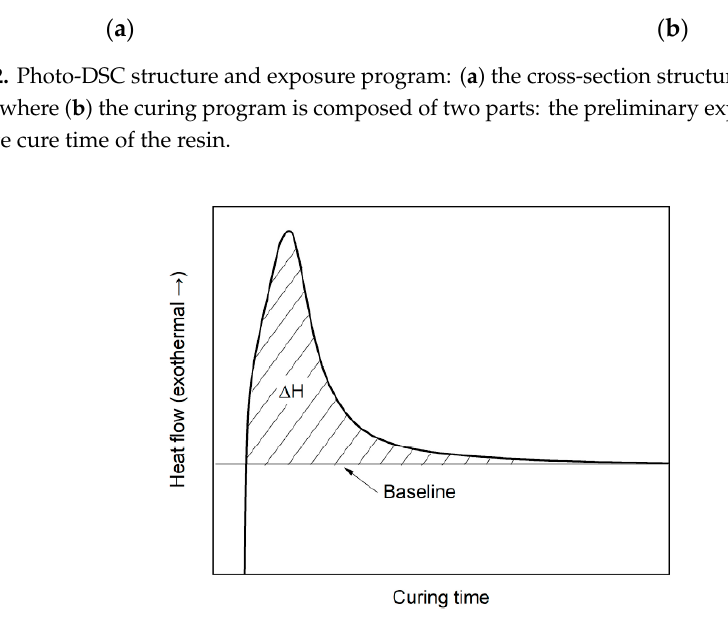
Figure 2. Photo-DSC structure and exposure program: ( a ) the cross-section structure of the photo- DSC furnace where ( b ) the curing program is composed of two parts: the preliminary exposure time and the complete cure time of the resin.